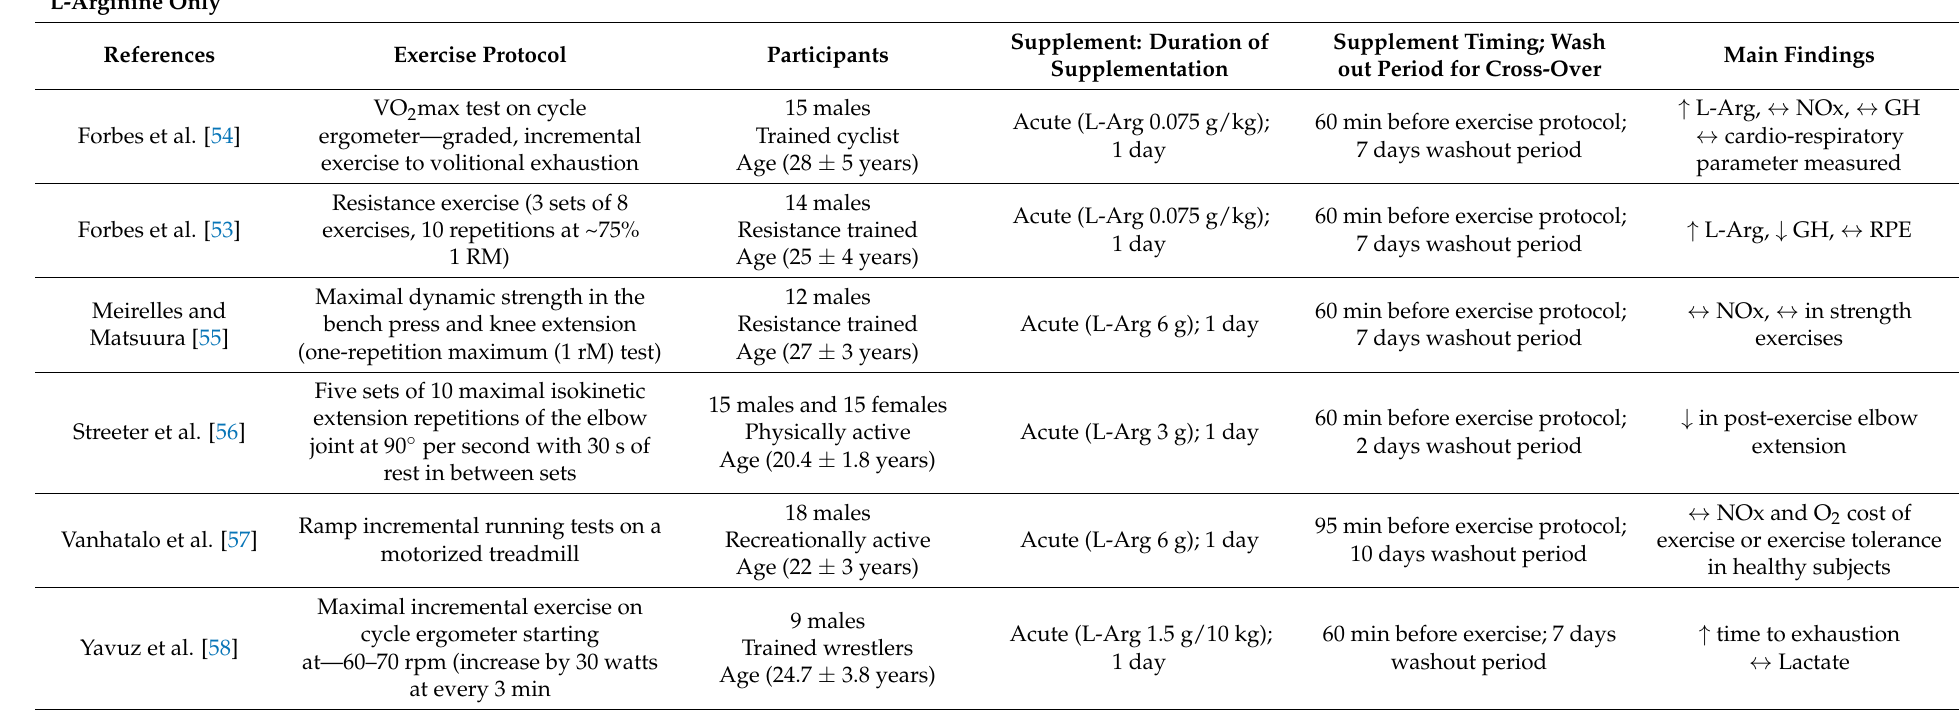
Table 1. A summary of studies in the